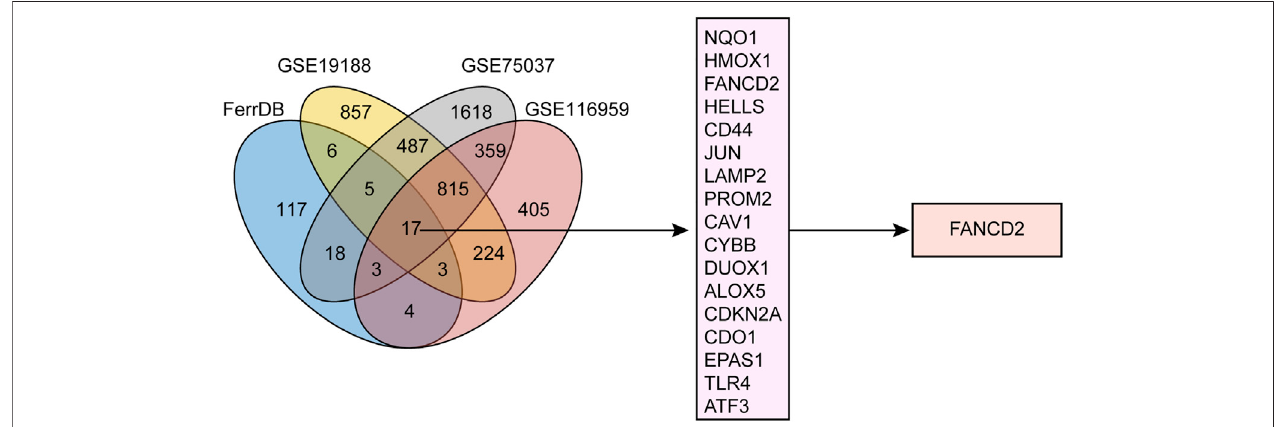
FIGURE 1 | Work fl ow of target screening. Venn diagram showing differentially expressed genes (DEGs) in NSCLC from three GEO cohorts alongside ferroptosis- related genes.